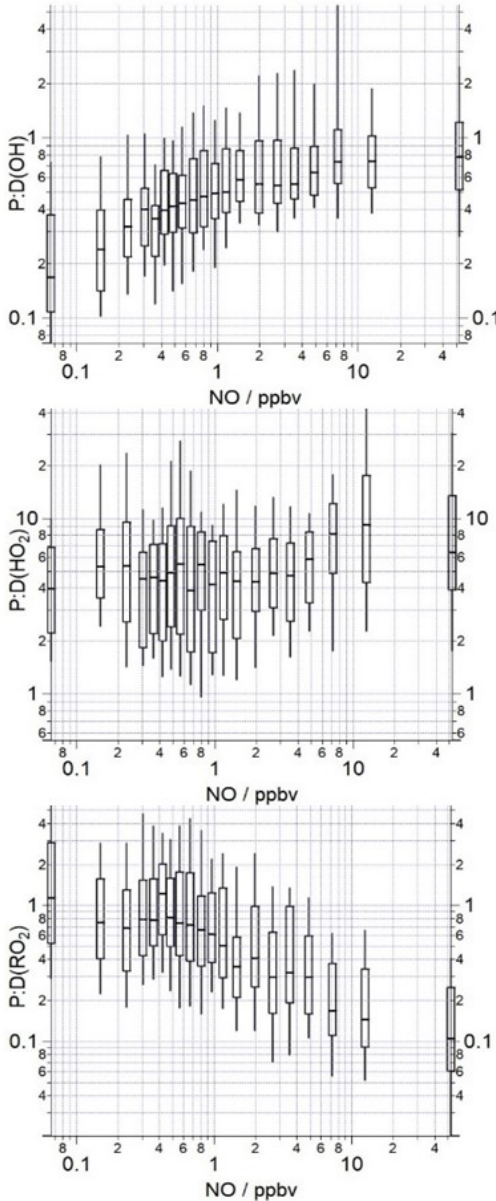
Figure 4. The median ratio of the OH, HO 2 and total RO 2 produc- tion rates to destruction rates binned over the NO mixing ratio range encountered during the campaign on a logarithmic scale. The box and whiskers represent the 25th and 75th and the 5th and 95th con- fidence intervals. The number of data points in each of the NO bins is ≈